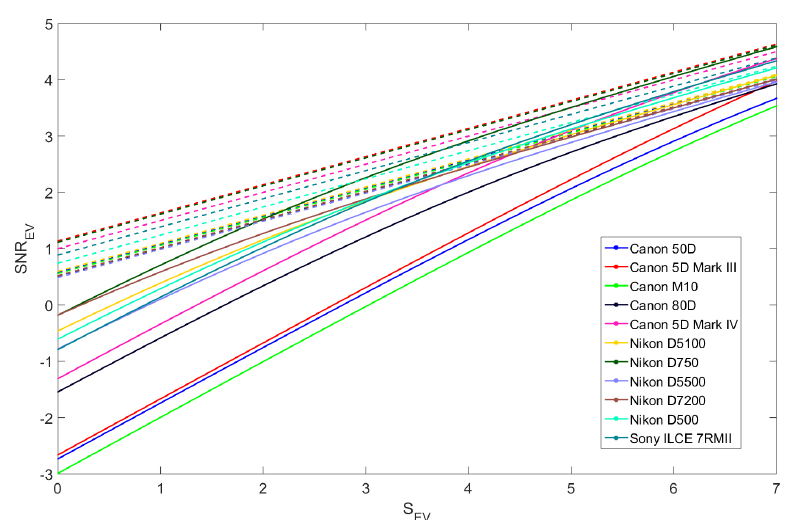
Figure 10. Pixel (solid line) and ideal (dashed line) SNR vs. RAW value for ISO